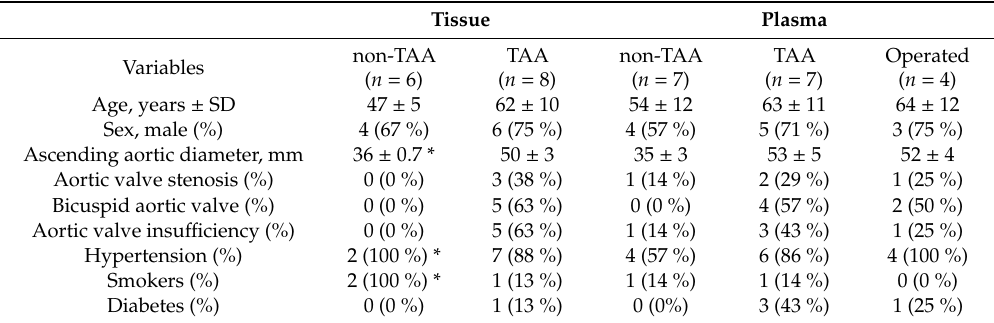
Table 1. Demographic and clinical characteristics of control and thoracic aortic aneurysm (TAA) patients selected for profiling of microRNA (miRNA) expression.